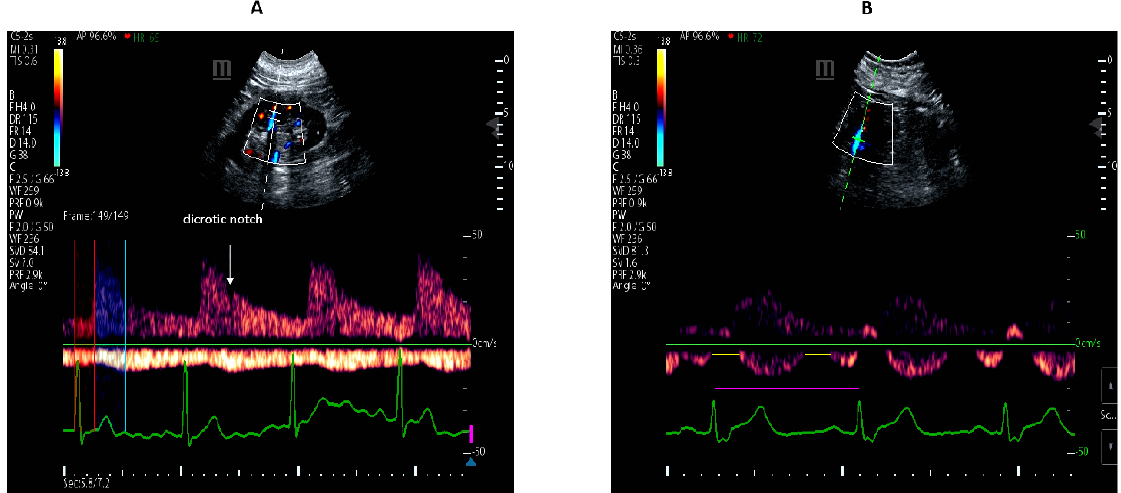
Figure 1. Panel ( A ) the arterial trace is shown above the green reference line. Renal Doppler resistive index is calculated as the ratio (S-D)/S, where S and D stand for peak systolic and end-diastolic velocities, respectively; arterial systolic time-intervals indicates the proportion of the cardiac-cycle during which there is an effective arterial perfusion and was calculated in milliseconds on the real-time ECG-trace as (renal pre-Ejection Time/renal Ejection Time). Renal pre-Ejection Time (red area) is calculated from onset of QRS complex to the foot of renal Doppler waveform. Renal ejection time (blue area) is measured from the foot of renal Doppler waveform to the dicrotic-notch of the renal pulse Doppler waveform; the continuous venous trace is shown below the green reference line. The venous impedence index is calculated as the peak maximum flow velocity minus the flow velocity at nadir, divided by peak maximum flow velocity. When venous flow is discontinuous, the index is 1.0, as the flow at nadir is 0. Panel ( B ) the discontinuous venous trace is shown below the green reference line. Venous systolic time-intervals indicates the proportion of the cardiac cycle measured in milliseconds from a QRS to the next QRS on the ECG-trace (pink line) during which there is no renal venous outlet flow (yellow lines) and is calculated as follows: (cardiac cycle time–venous flow time/cardiac cycle time). When venous flow is continuous, the v-STI is 0, as the venous flow time equals the cardiac cycle